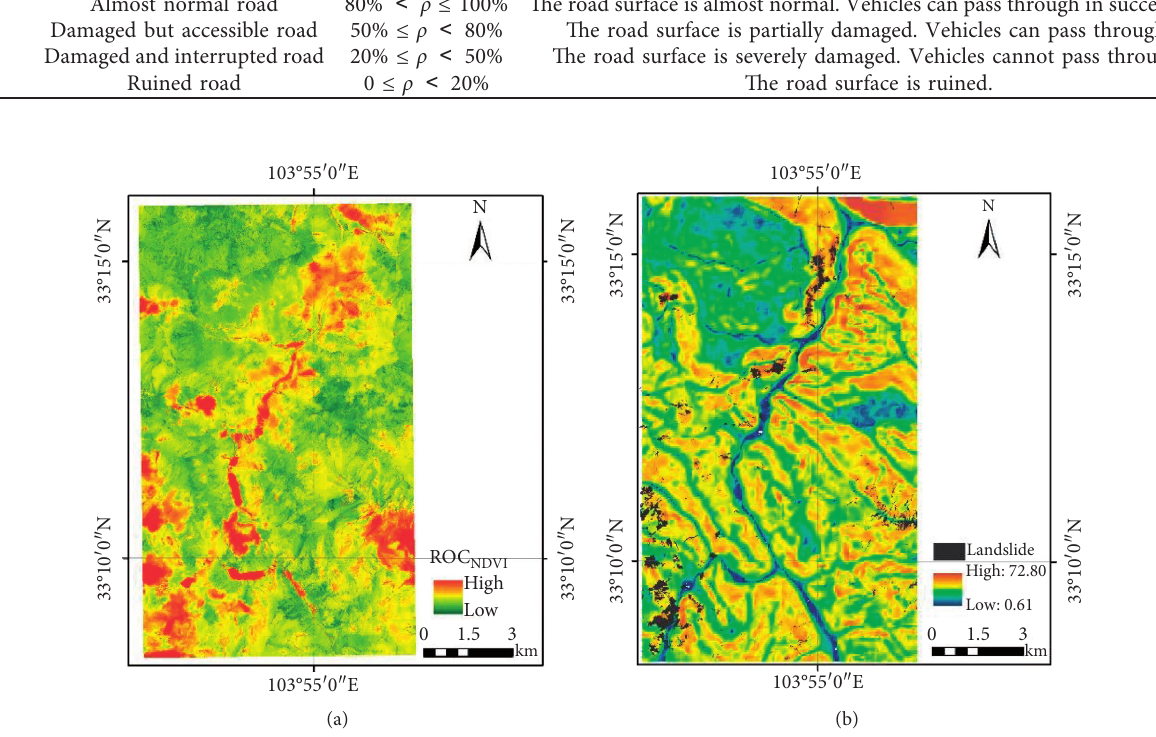
Figure 6: Results are exported to vector layers. (a) Rate of change (ROC) for NDVI between pre- and postearthquake images. (b) Detected landslides against slope in the study area.